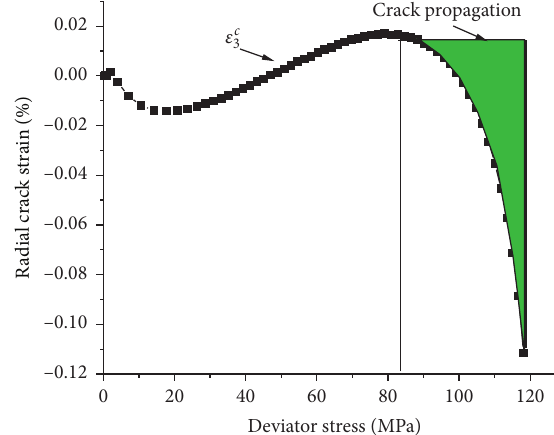
Figure 16: Rock radial crack strain curve of sample 10–5.